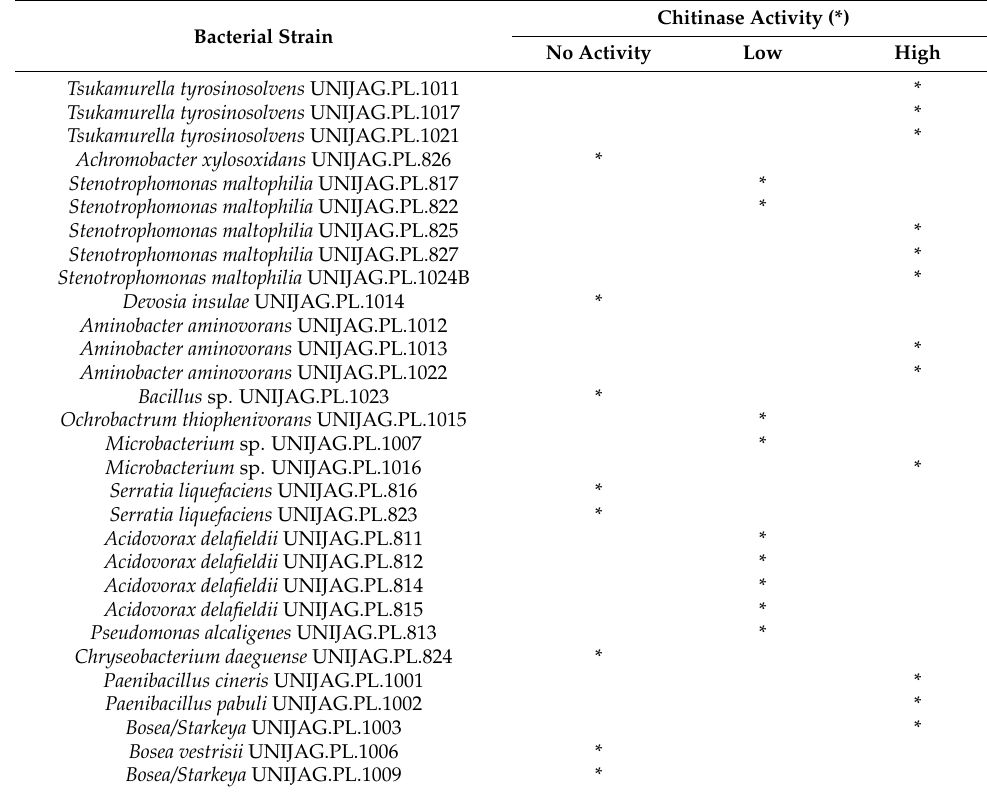
Table 2. Chitinase activity of bacterial